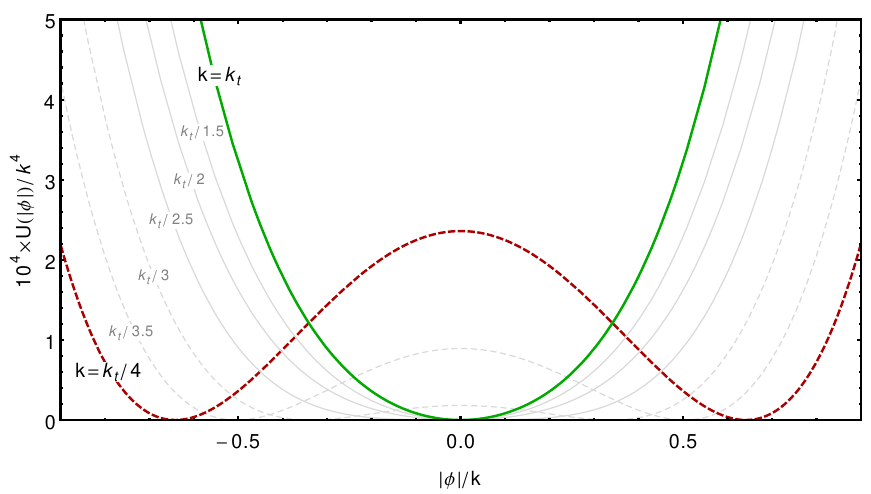
Figure 3 . Numerical evolution of the scalar potential, starting from the initial condition U=k 4 = u (cid:3) at k = k t (green continuous line). Thin (dashed) lines depict the evolution before (and after) symmetry breaking. The latter occurs at k=k t (cid:25) 1 = 2 : 5. At k=k t (cid:25) 1 = 4 (red-dashed line) a non- trivial minimum has clearly developed. The gravitational, gauge and Yukawa contributions are chosen as A = 1 = 10, (cid:11) g = 0 and (cid:11) y = 1 =